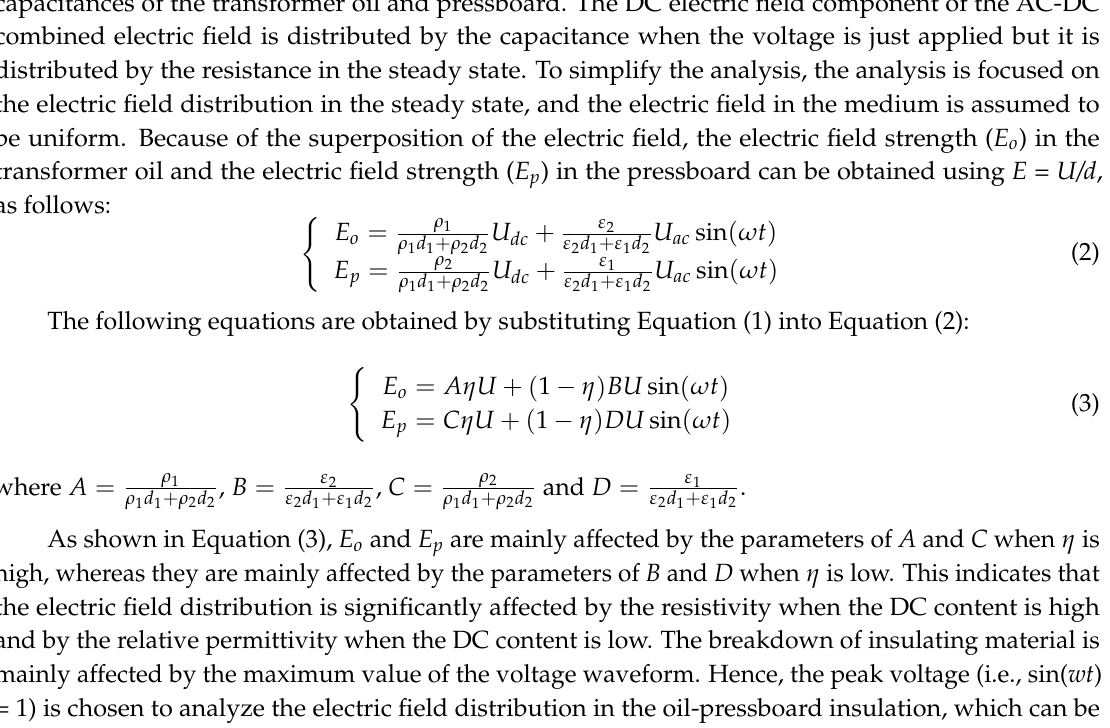
6 of 13 Figure 6. Breakdown voltage of oil-pressboard insulation under AC-DC combined voltage. 4. Mathematical Model of Breakdown of Oil-Pressboard Insulation 4.1. Simplified Model To study the effect of DC content on the electric field distribution in the oil-pressboard insulation more directly, the oil-pressboard insulation model, shown in Figure 1, is simplified to a physical model of the oil-pressboard insulation, as shown in Figure 7. E o and E p , ε 1 and ε 2 , ρ 1 and ρ 2 , and d 1 and d 2 are the electric-field strengths, relative permittivity, resistivity, and thicknesses of the transformer oil and pressboard, respectively.